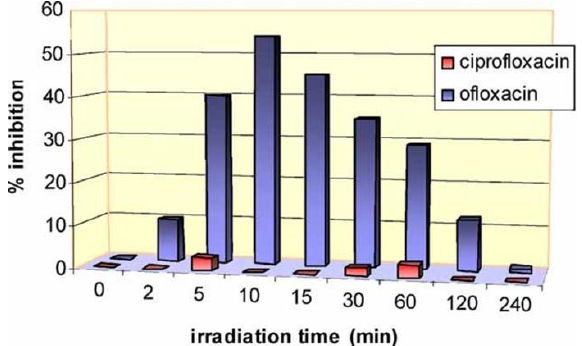
Figure 8. Inhibition (%) of the luminescence of bacteria Vibrio fischeri as a function of the photocatalytic treatment time for ofloxacin and ciprofloxacin. Reprinted with permission from [64], copyright 2008, John Wiley and Sons .